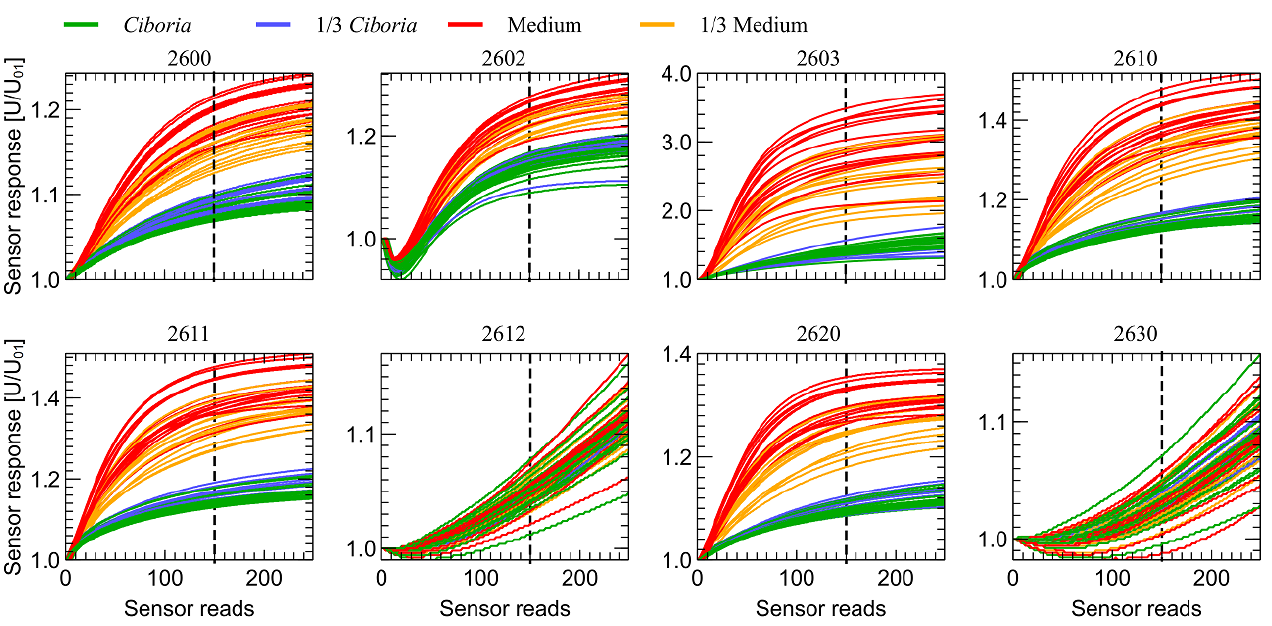
Figure 6. Sensors transient response in the first stage of the observation time (after the opening of the sensor chamber shutter), versus time elapsed from the chamber shutter opening. The sensor’s response voltage is normalized by the voltage at the beginning of the stage of observation time U 01 . Variants of the measured samples are marked by color lines. The sensor type is indicated above the subfigures. The vertical dotted line indicates the observation moment at which data presented in Figure 8 are collected.